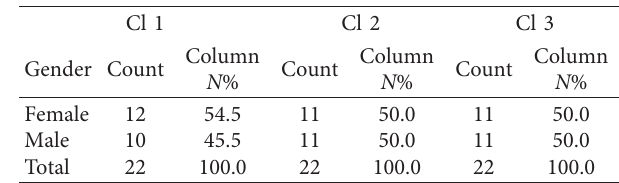
Table 1: Gender distribution based on sagittal skeletal pattern.